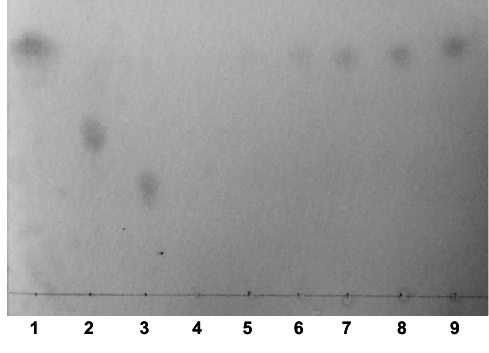
Figure 5. Thin-layer chromatography of the degradation products. Lanes 1–3: Standards of mono-, di-, and tri-galacturonanos, respectively; Lanes 4–9: The products of CbPelA incubated with polygalacturonic acid for different times (0, 1, 2, 4, 8, and 16